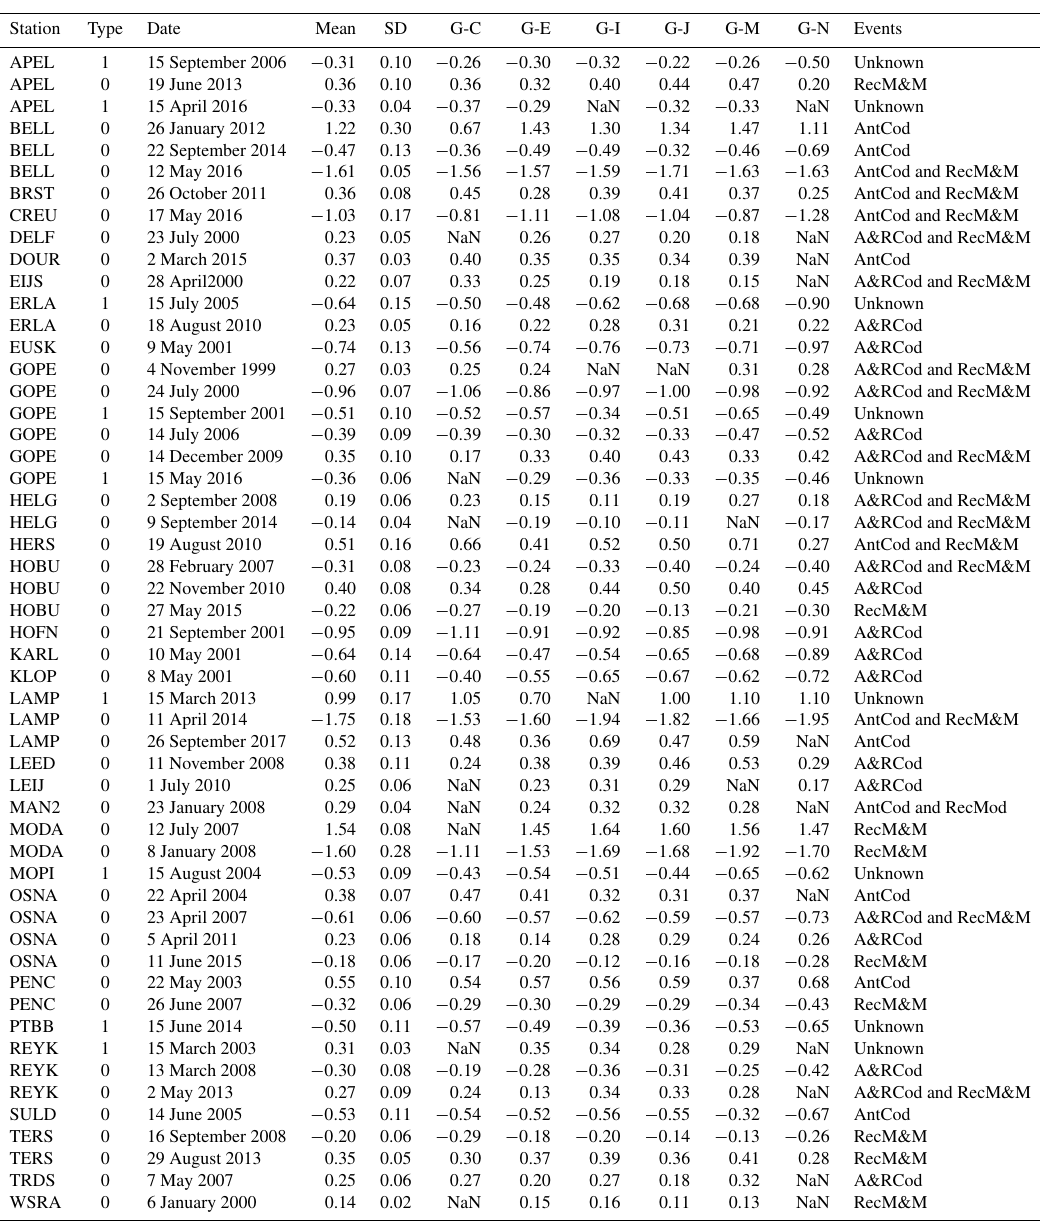
Table A1. The identified changepoints in GPS IWV time series. The Type 0 and Type 1 are changepoints with and without changes in instrumentation as documented in GPS station log files, respectively. The full names of the Type-0 changepoint events are shown in Table A2, and the Type-1 changepoints are labelled as Unknown. G-C, G-E, G-I, G-J, G-M, and G-N indicate the GPS IWV changepoints in kilogram per square metre estimated by comparing it to CFSR, ERA5, ERAI, JRA-55, MERRA-2, and NCEP-2, respectively. The NaN indicates that the changepoint in the specific GPS-reanalysis comparison is insignificant at a confidence level of 99%. The mean and SD are the mean value and standard deviation of each